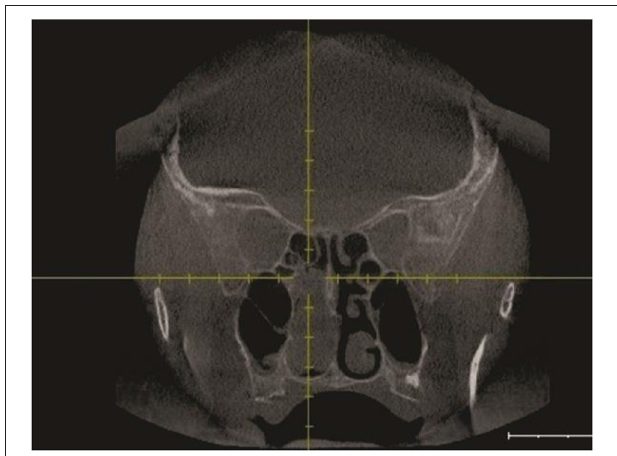
FIGURE 2 | Pre-operative CT scan coronal